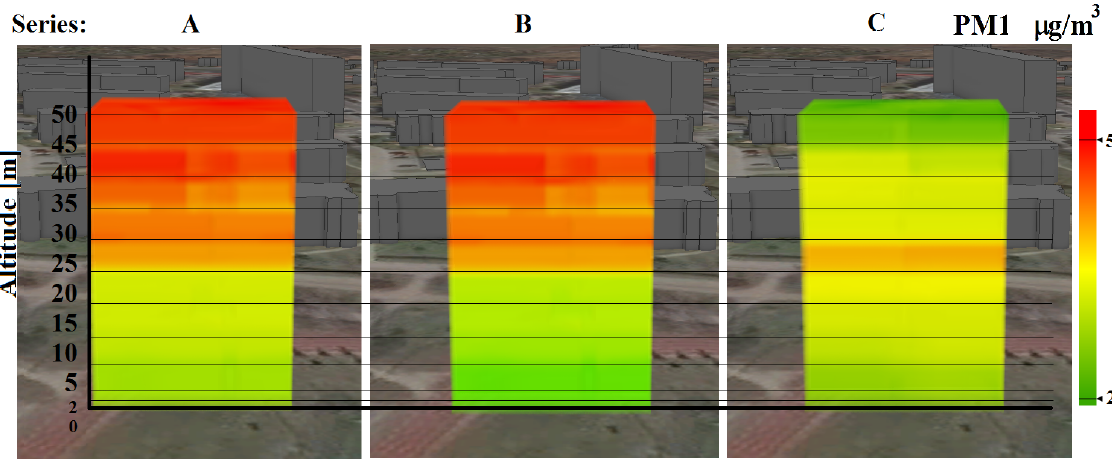
Figure 7. Spatial distribution of PM 1 . 0 pollution with altitude for three measurement series in the VEIP station area.